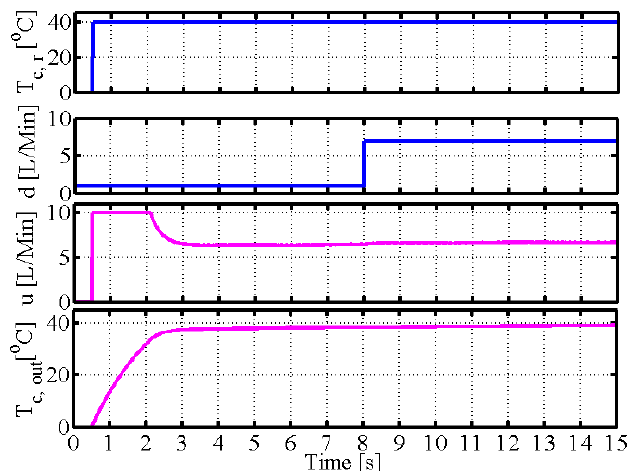
Figure 16. Simulation of PID without